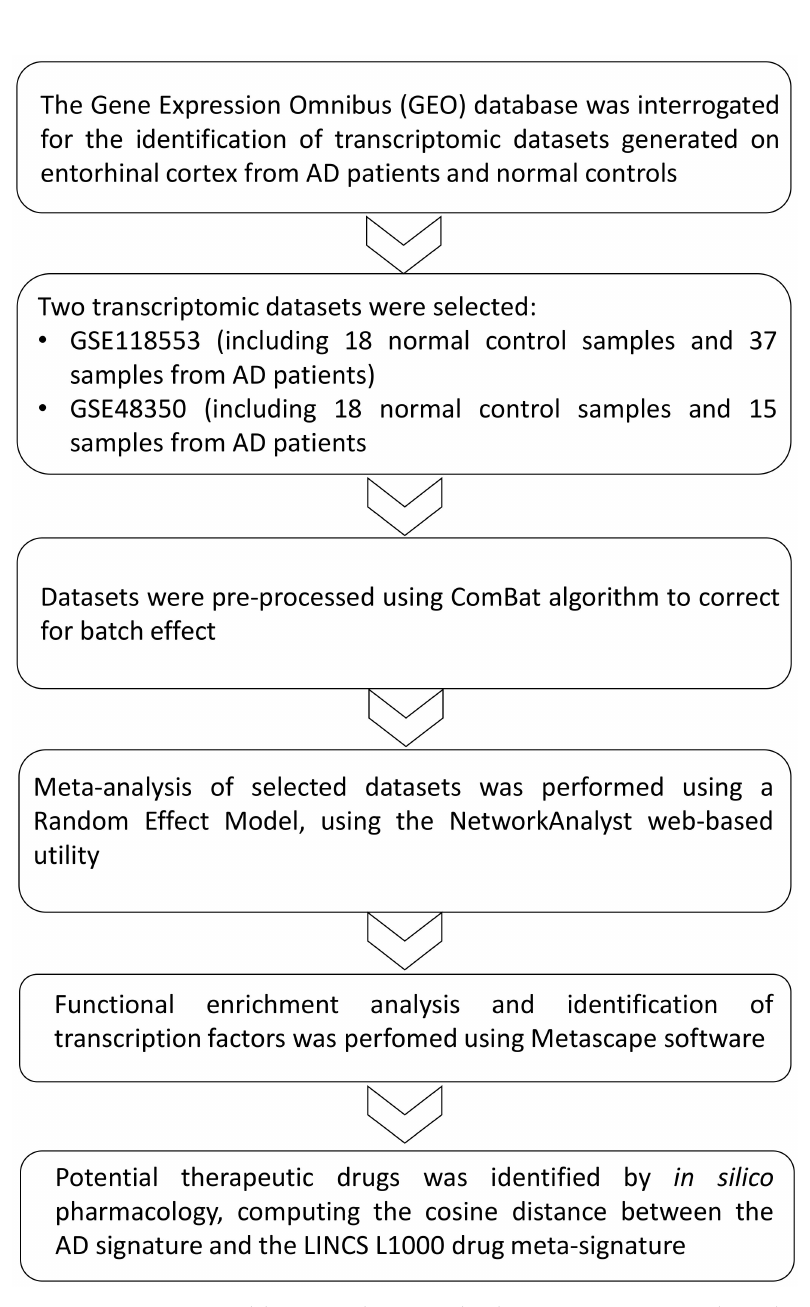
Figure 1. Experimental layout. The GEO database was interrogated to identify transcriptomic data sets generated on the entorhinal cortex of AD patients and normal subjects. Two data sets (GSE118554 and GSE48350) passed the inclusion criteria and were selected for further analysis. After a preprocessing step, the differentially expressed genes (DEGs) were obtained by performing a meta- analysis using a random-effect model. Functional enrichment analysis was performed on the DEGs, and an in silico pharmacology approach was employed to predict potential novel therapeutic